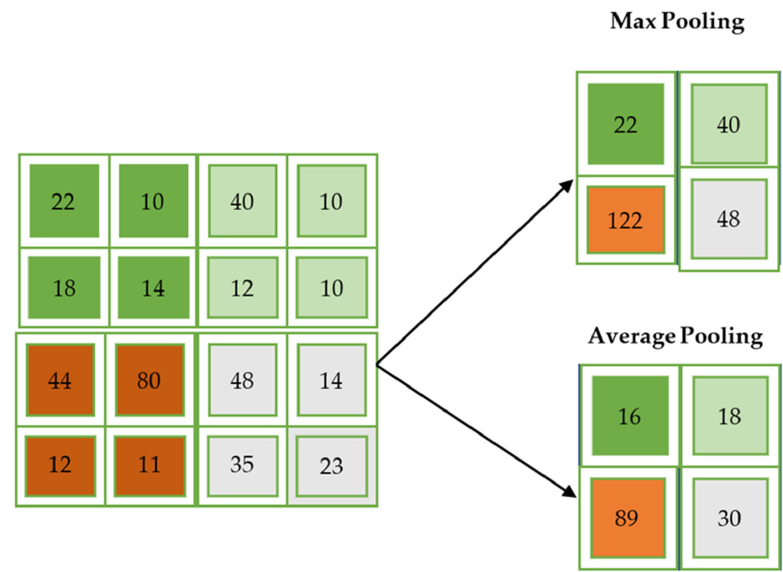
Figure 4. Maximum and average pooling.